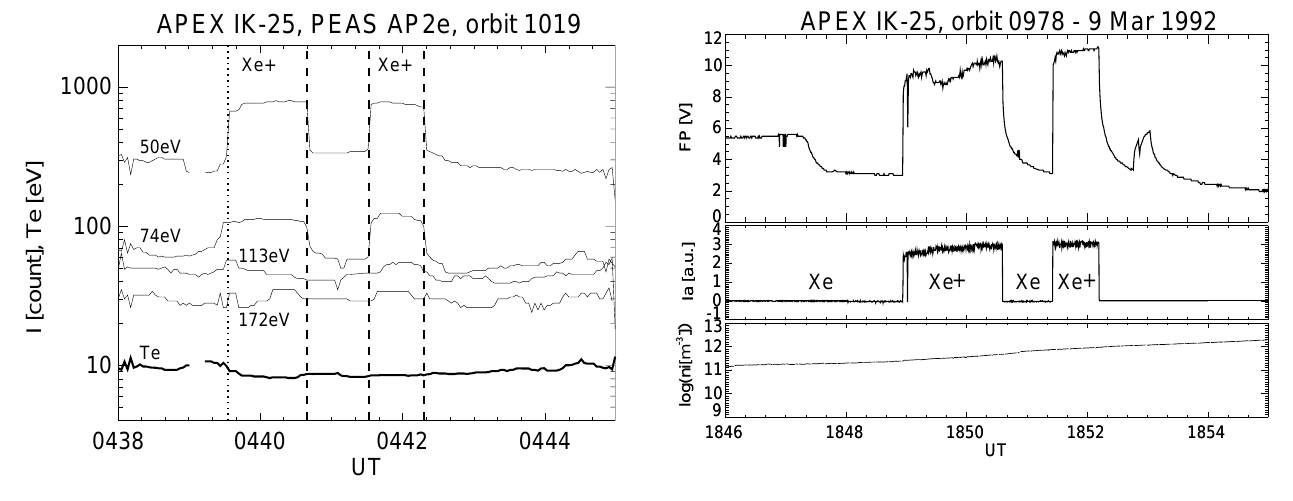
Fig. 5. Electron currents at four different energies measured by the PEAS spectrometer during a sequence of the Xe plasma re- lease. The heavy line shows the electron temperature computed from Eq. (16) using counts on two lowest energies. The intervals of the Xe plasma release are denoted as Xe + .